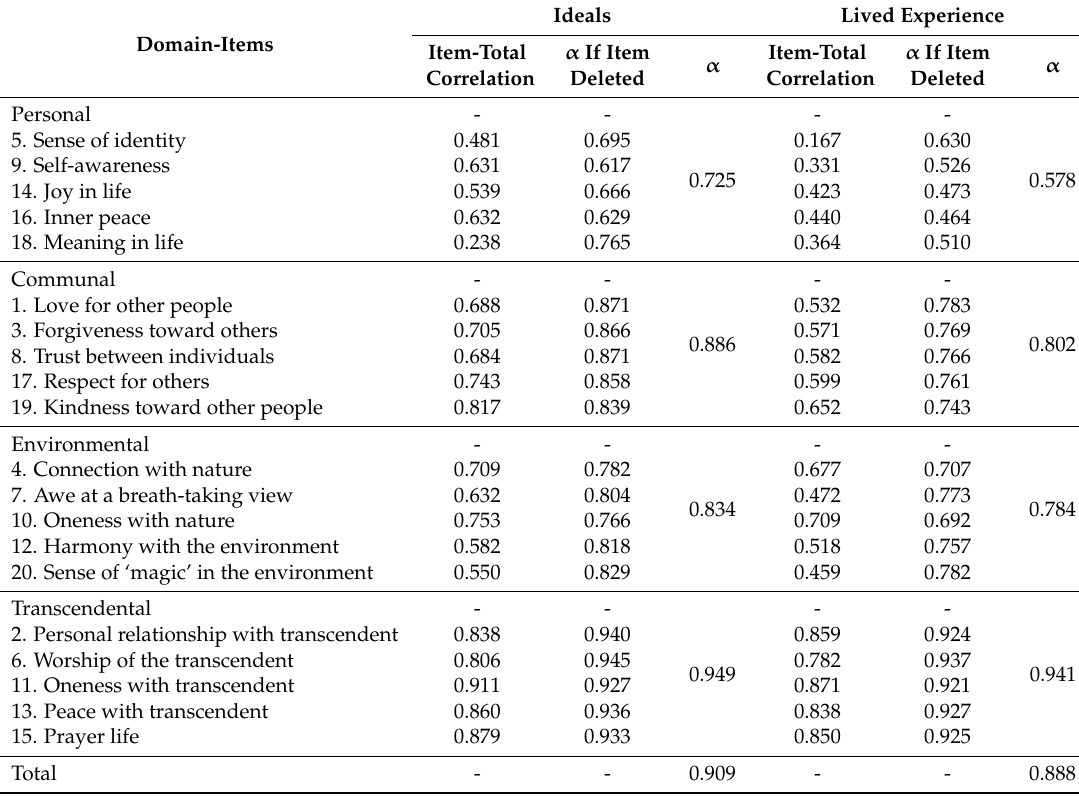
Table 2. Reliability statistics for the two sections of Spiritual Well-Being Questionnaire